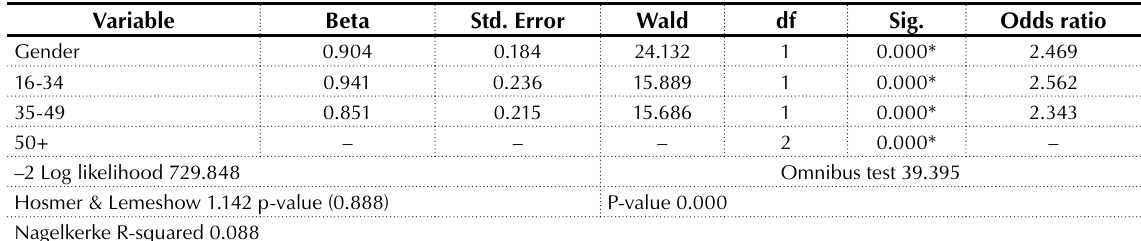
Table 5. Binary logistic regression